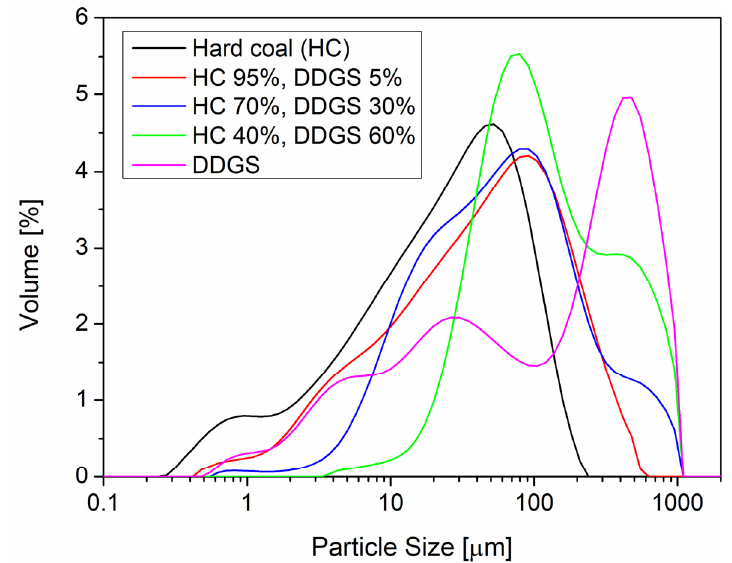
Figure 4. Particle size distribution for DDGS with hard coal mixtures.